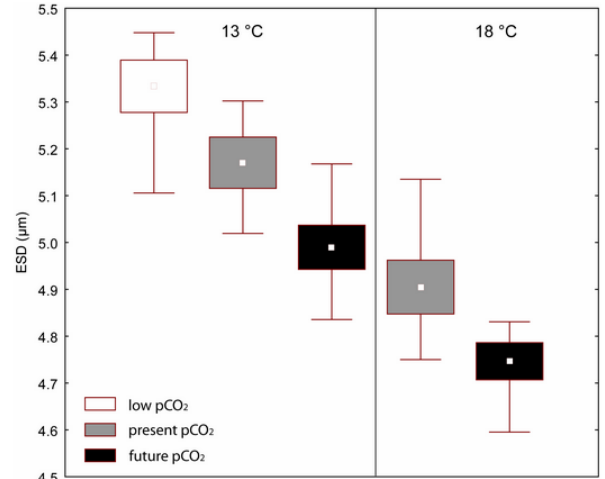
Fig. 5. Mean particle size of CSP for each treatment. The cen- tral marker denotes the mean, the standard error is given by the box boundaries, and the whiskers represent the minimum and maximum mean values of the size measurement on three time points in dupli- cate cultures ( n =6). The white box represents the low CO 2 treat- ment, the grey shaded boxes the present CO 2 treatments, and the black boxes the future CO 2 treatments. The right-most two boxes represent the 18 ◦ C